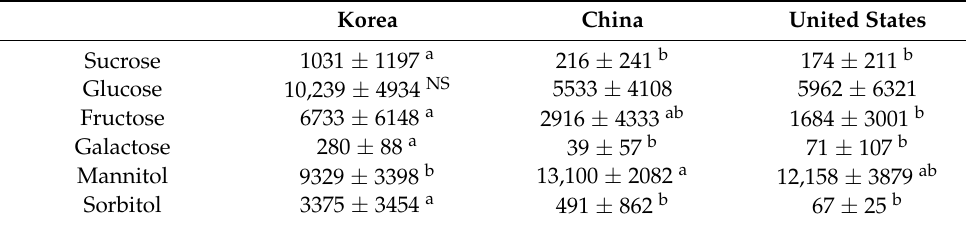
Table 3. Free sugar contents of commercial kimchi manufactured in Korea, China, and the United States (mg/kg).